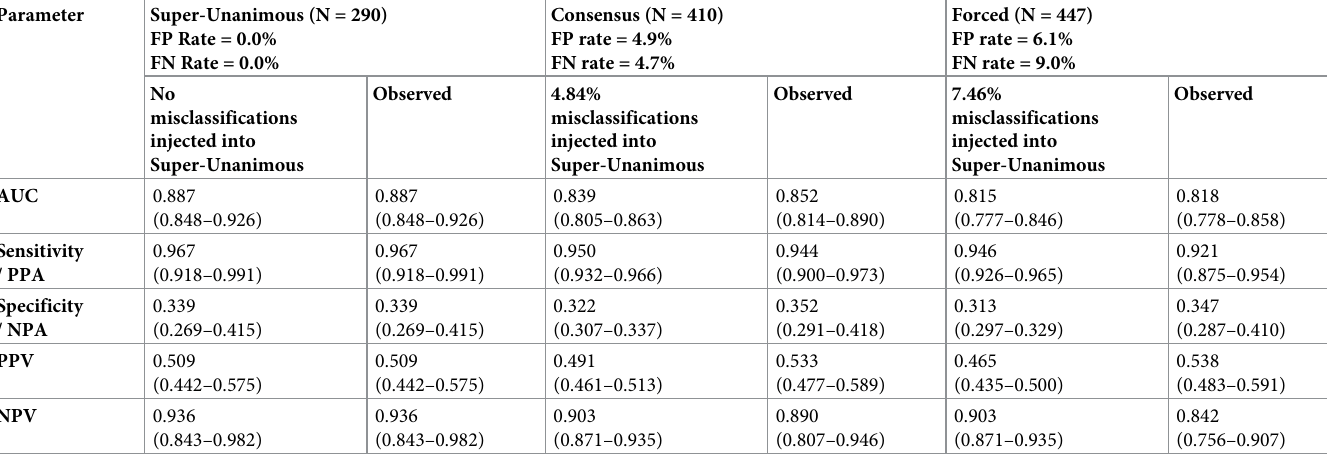
Table 2. Testing the models: Simulated vs. observed effect of comparator noise on test performance. Parameter Super-Unanimous (N = 290) FP Rate =